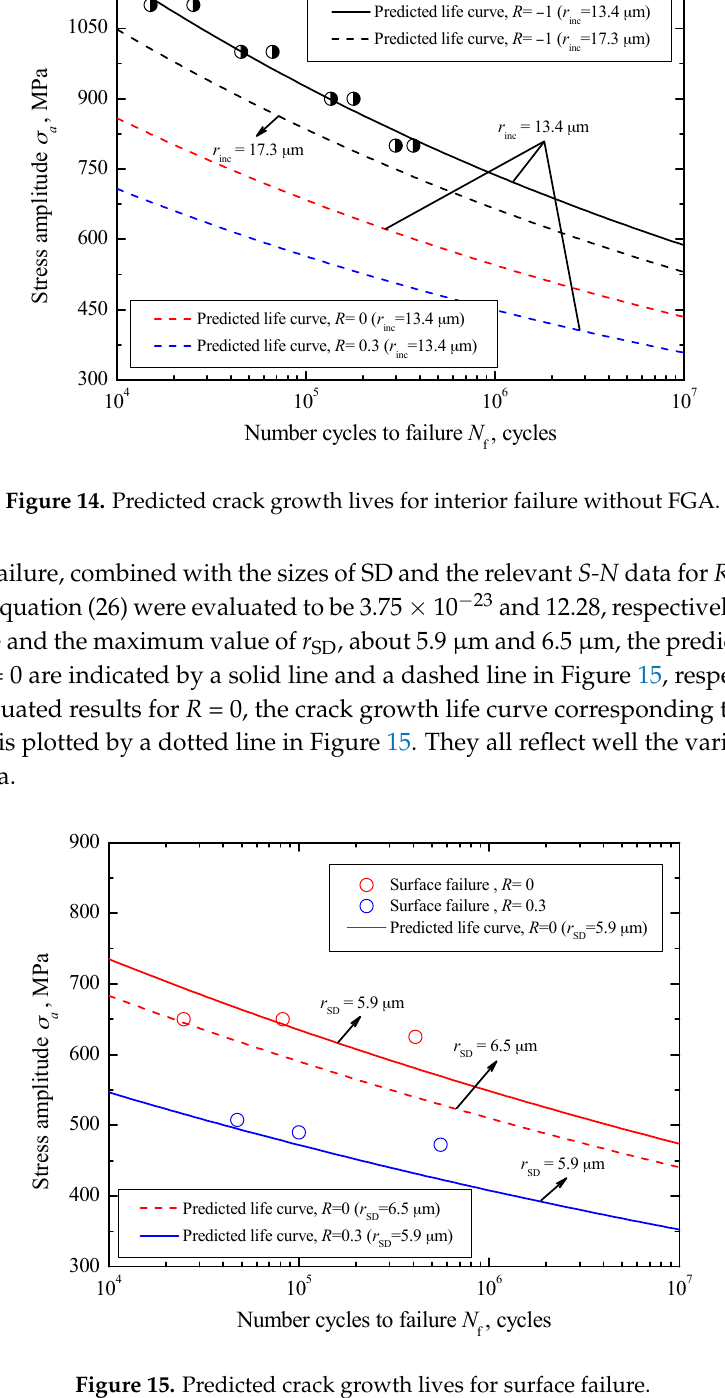
Interior failure without FGA , R =  1 Predicted life curve, R =  1 ( r Predicted life curve, R =  1 ( r